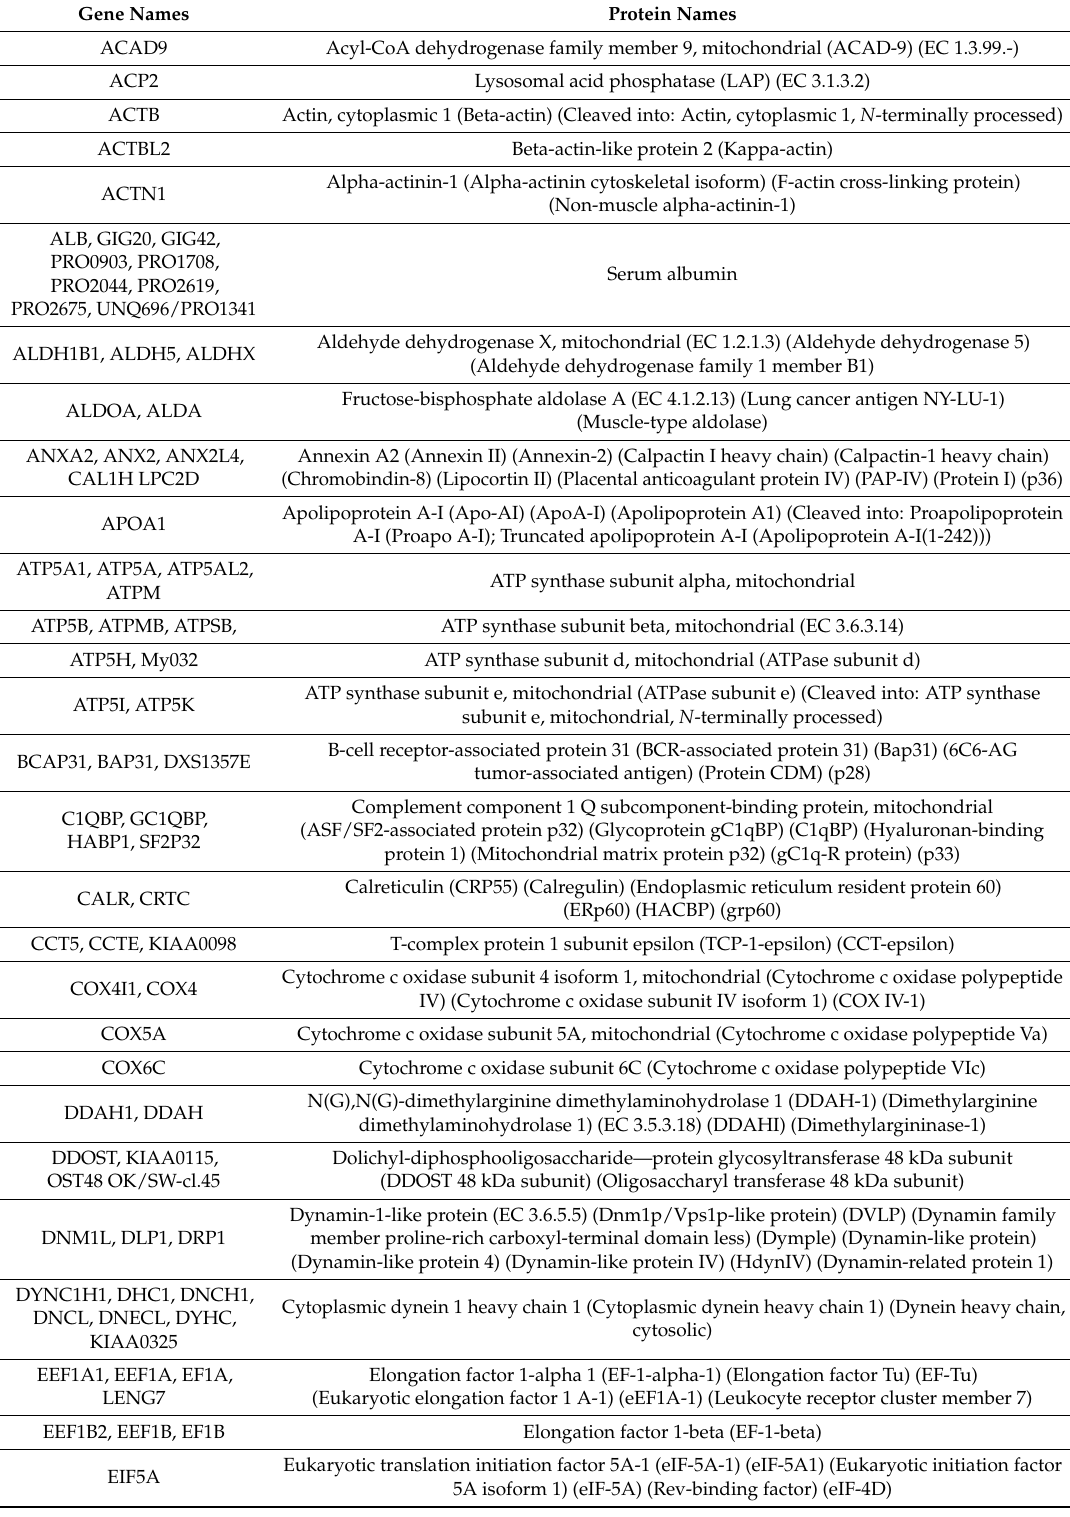
Table 3. List of binding partners of the mitochondrial-shaping proteins altered in Parkinson’s disease (Table 2) that are found in the list of proteins modified in the context of Parkinson’s disease (Supplementary Table